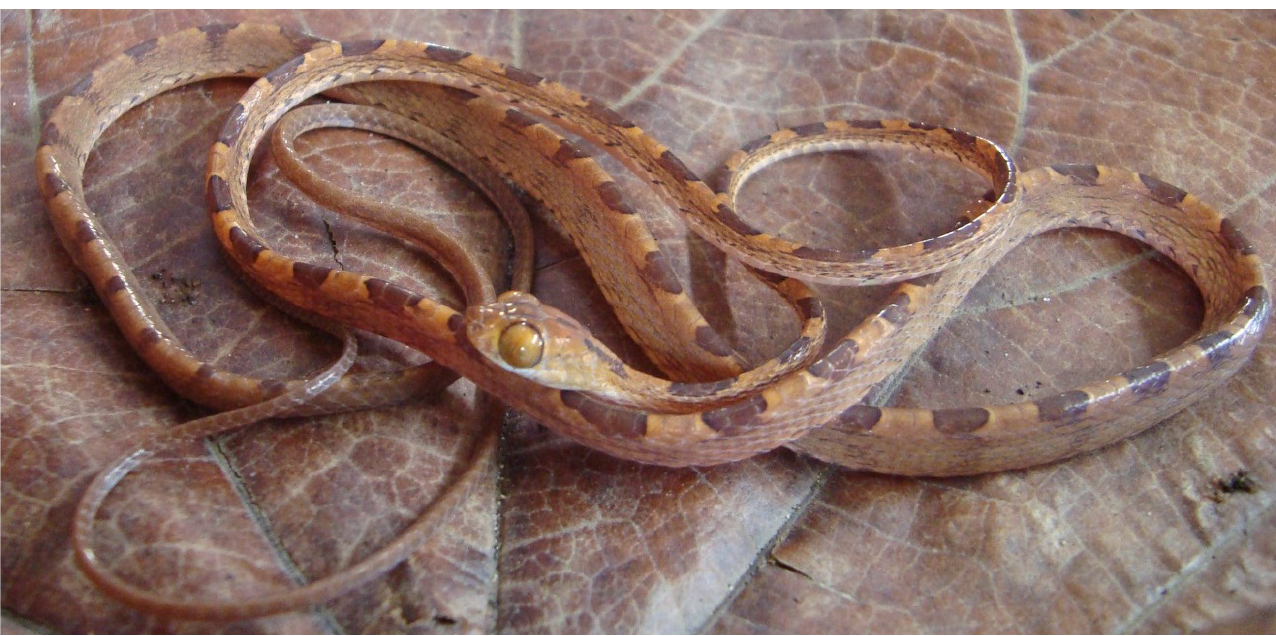
Imantodes chocoensis Figure 3. Uncollected specimen of from Pianguita-Bazán, Buenaventura, Valle del Cauca 3°50’32.55” N, 77°11’54.60” W, 25 m. Photo by: Andres F. Vinasco-Mondragon.